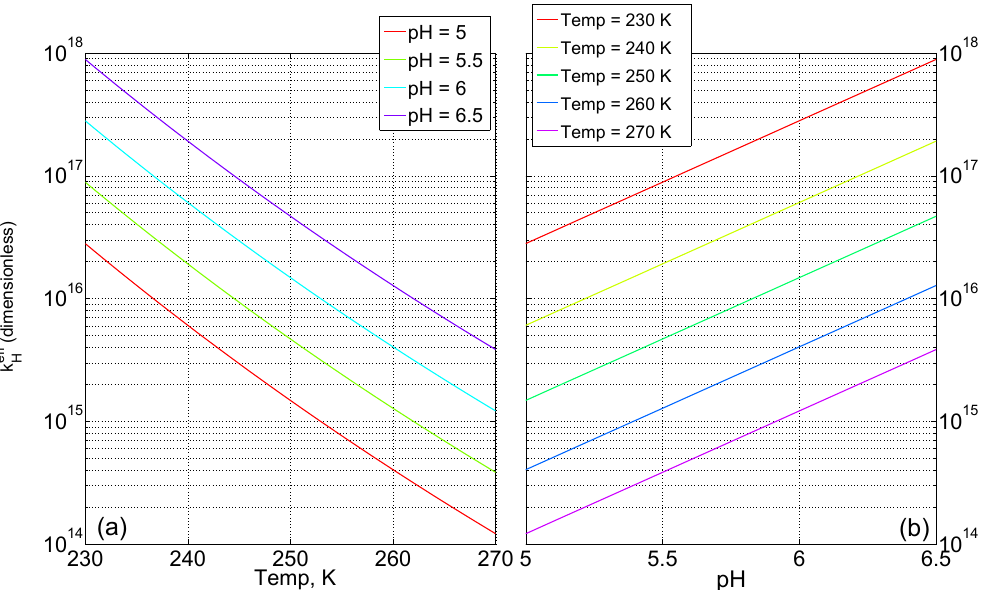
Figure B3. The dependence of the effective Henry’s law coefficient, k